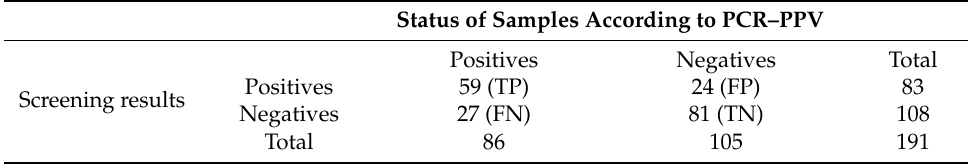
Table 4. Results of the performance assessment for PPV using the POC system. Status of Samples According to